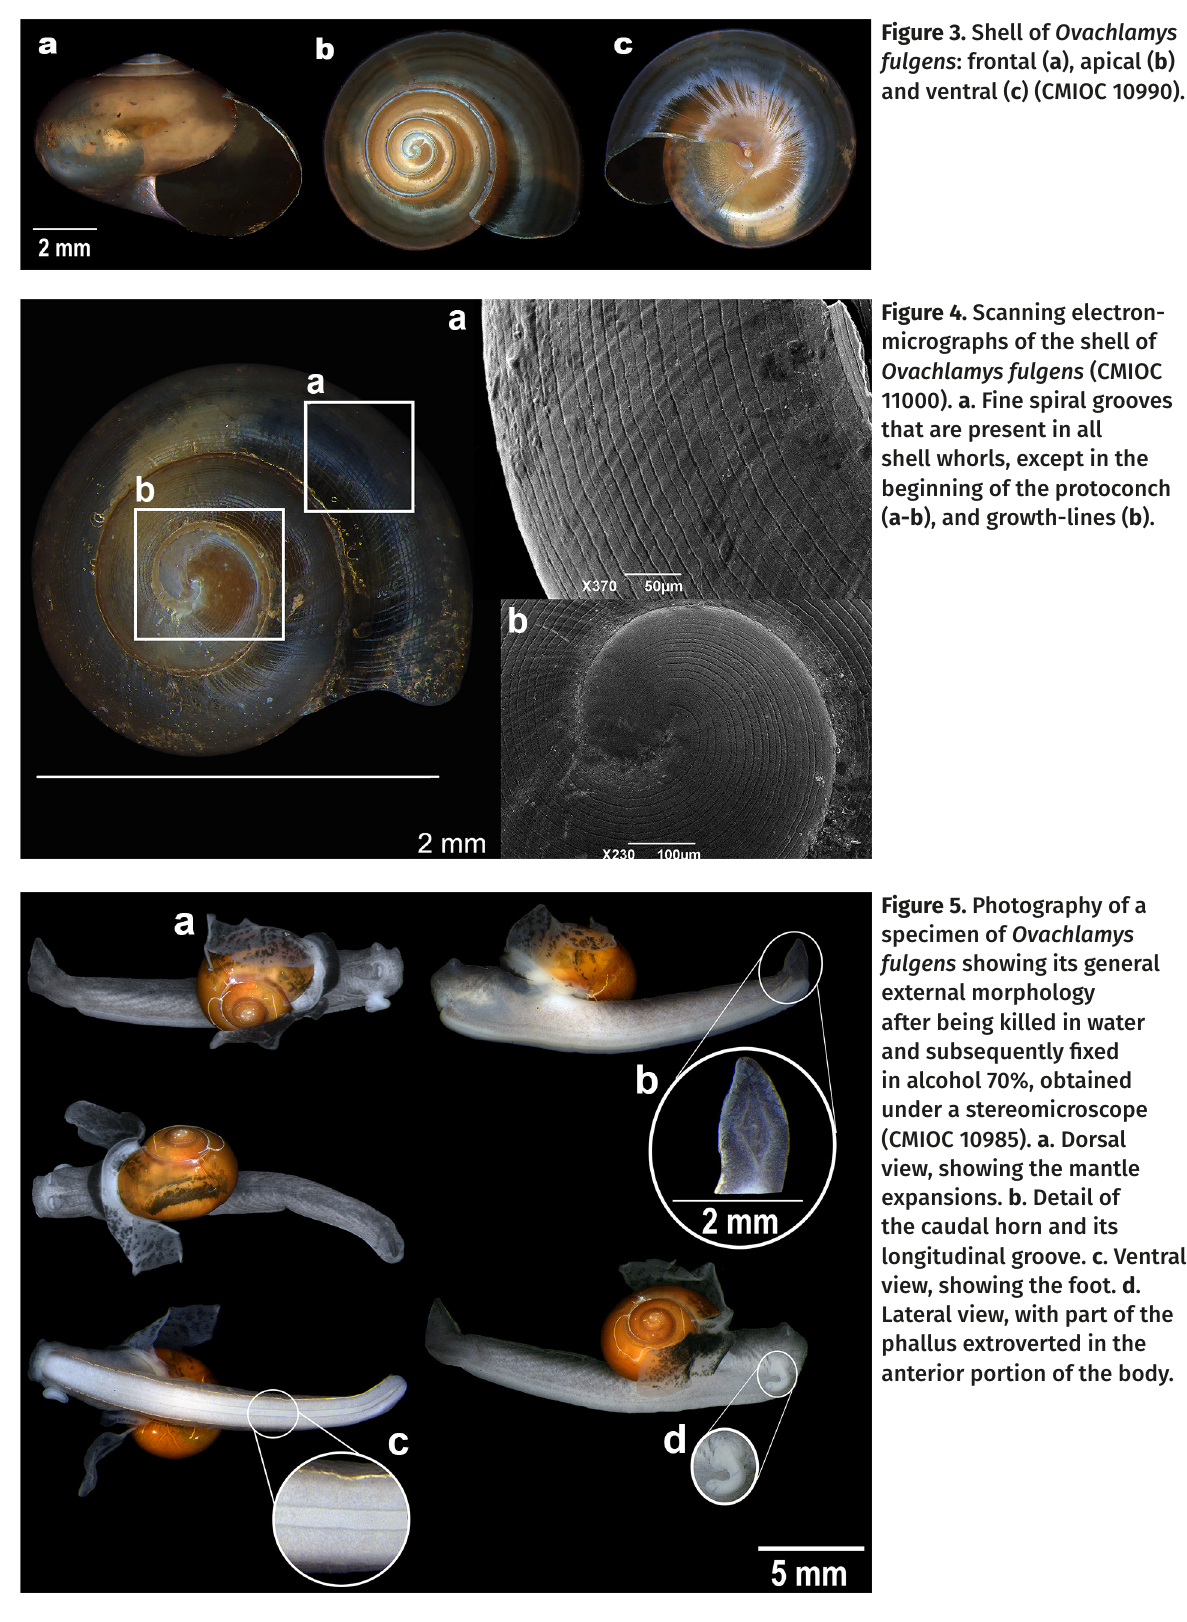
Figure 3. Shell of Ovachlamys fulgens : frontal ( a ), apical ( b ) and ventral ( c ) (CMIOC 10990).